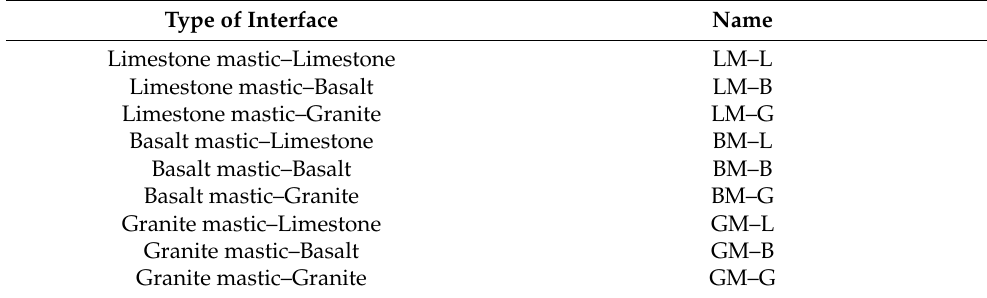
Table 6. Specimen designs and names of asphalt mastic–aggregate